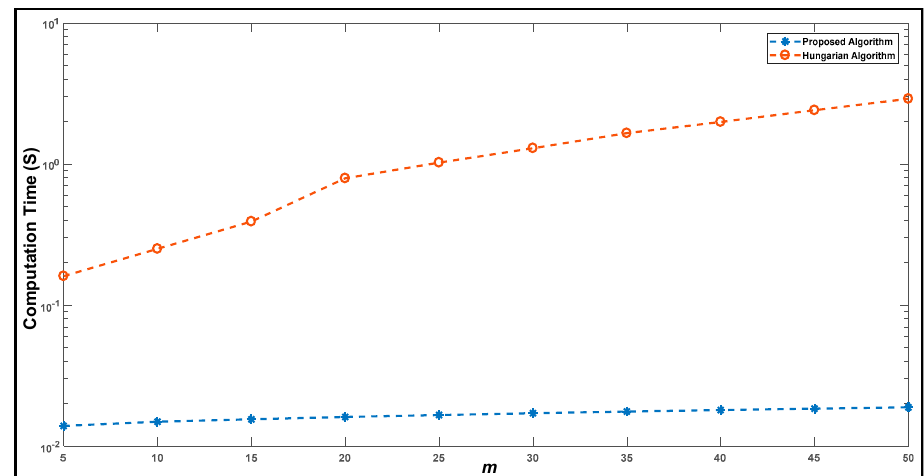
Figure 5. Computation time comparison of the proposed scheme with the Hungarian algorithm vs. m .